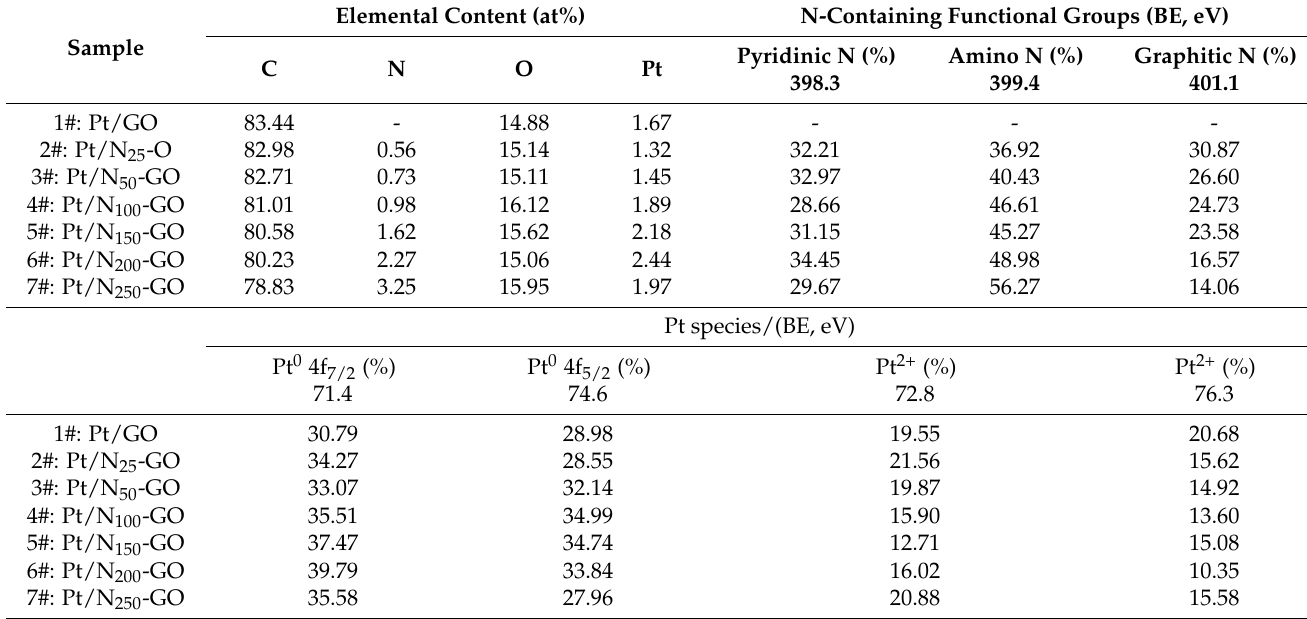
Table 1. XPS data and possible chemical compositions and states of N and Pt in the seven